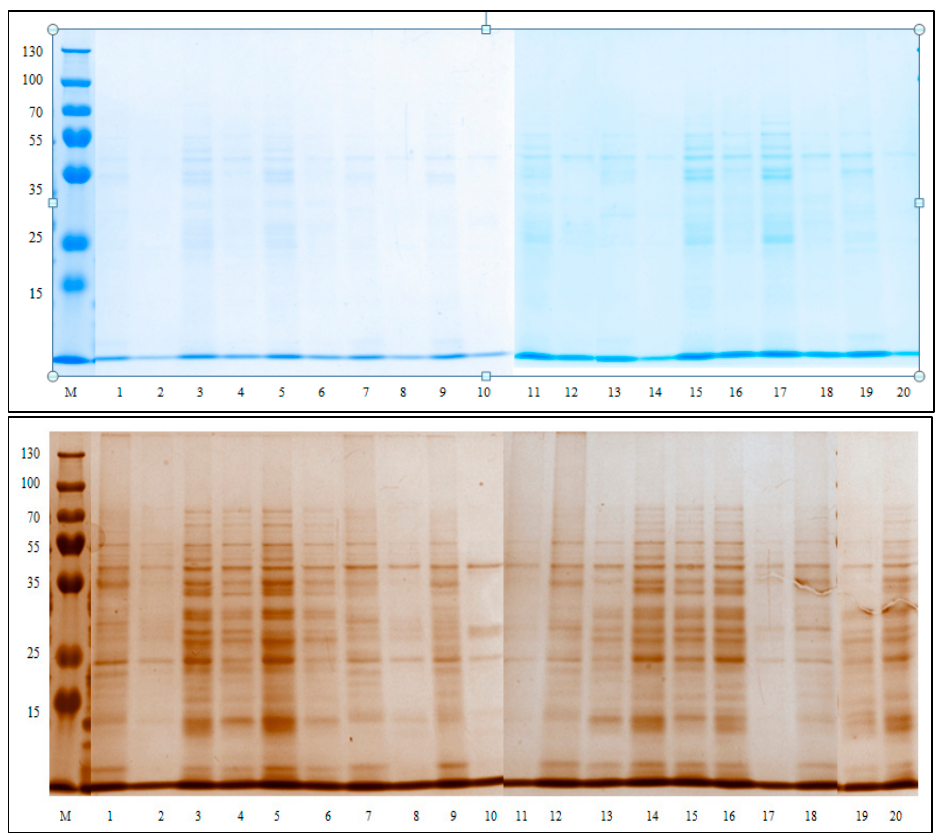
Figure 4. Polyacrylamide gels after migration of colored samples with Coomassie Brilliant Blue